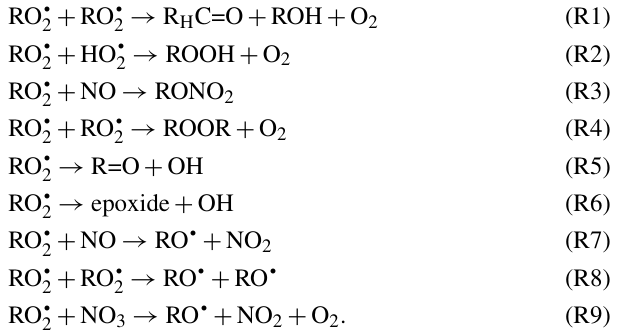
FIGAERO-CIMS and an extractive electrospray ionization time-of-flight mass spectrometer (EESI-ToF-MS). However, the detailed speciation depends on analytical method to some extent. Moreover, the HOM composition in the particle- phase was found to depend on aging time and reaction con- ditions such as dark versus light (Bell et al., 2021; C. Wu et al.,